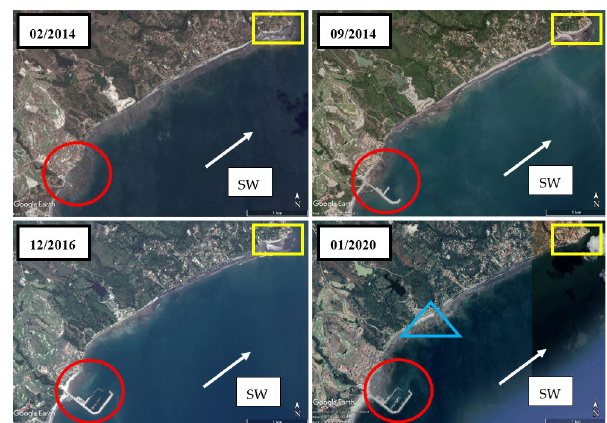
Figure 17. Breakwater zone (red circle) located approximately 5 km away from Punta Barco Viejo Beach (yellow rectangle). The presence of two breakwaters (blue triangle) near the breakwater is observed. Images used from the historical viewer of Google Earth Pro.